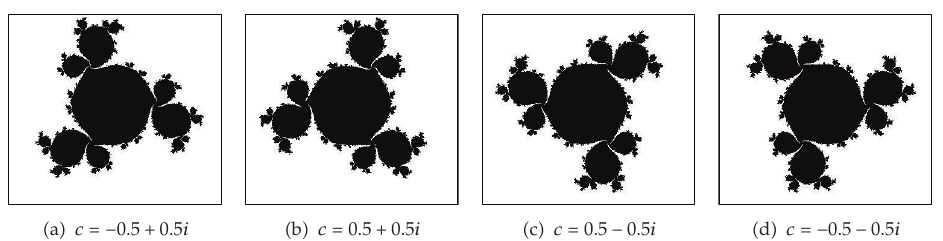
Figure 1: The generalized J sets without any perturbation when α (cid:6) 3.